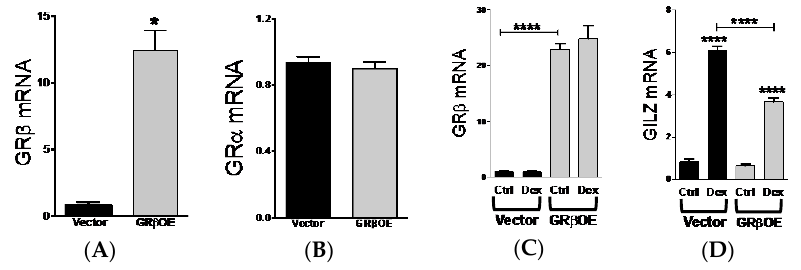
Figure 3. GRβ overexpression reduces dexamethasone responsiveness in C 2 C 12 myoblasts. ( A ) Myoblasts